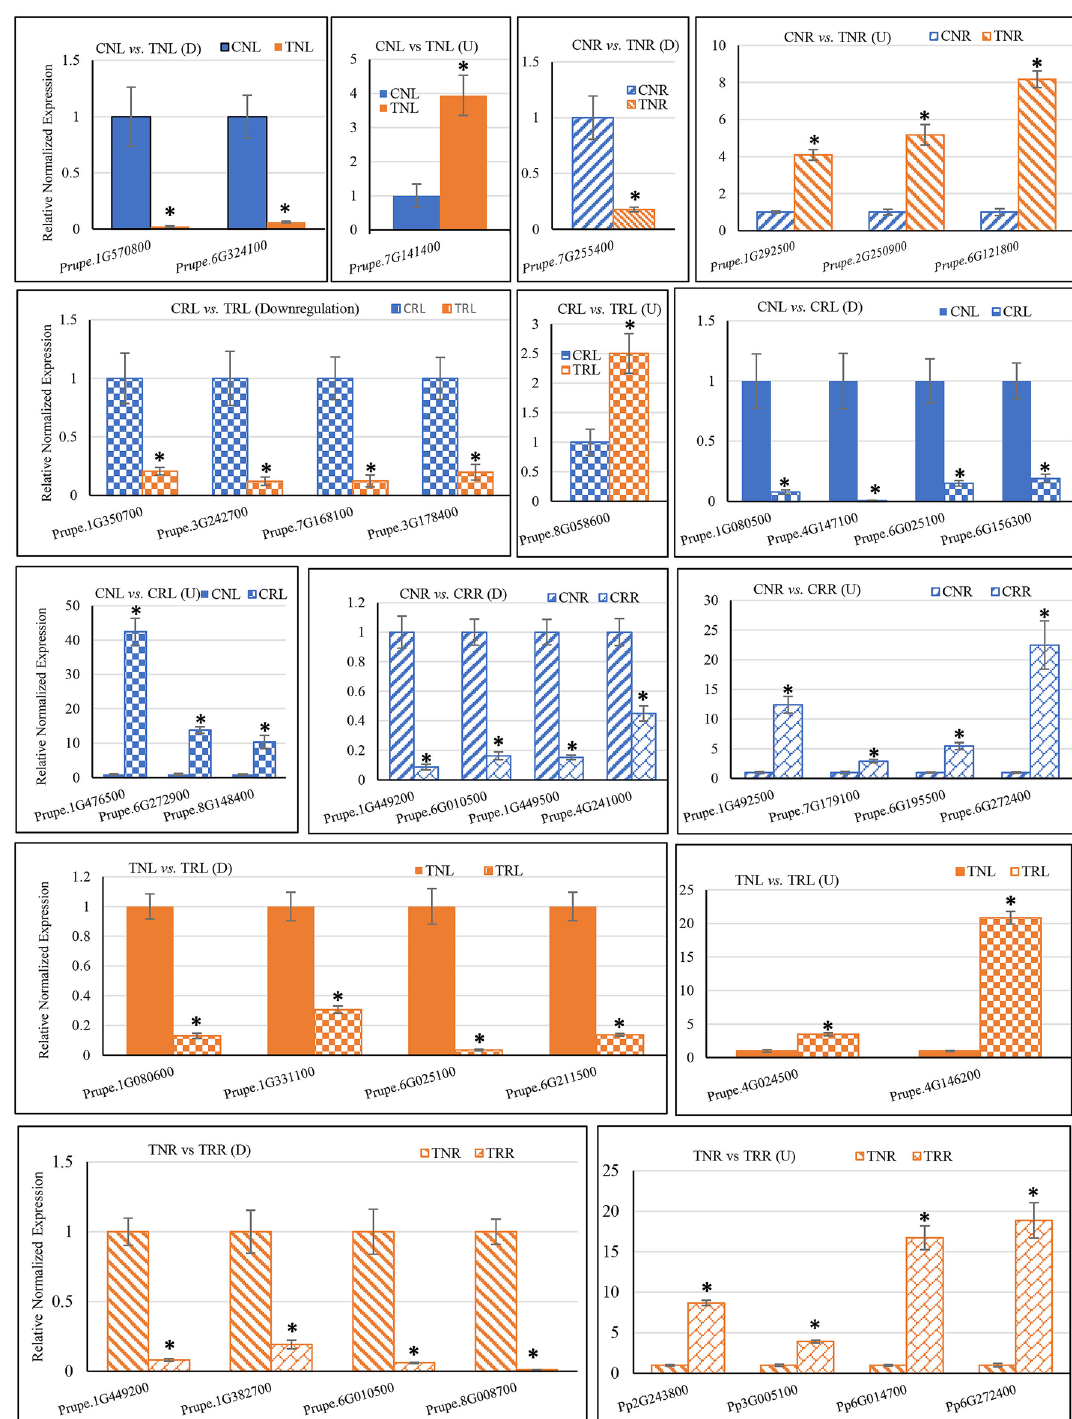
Figure 3. qRT-PCR validation of gene expression observed in RNA-Seq data. The Y -axis indicates relative normalized expression, and the X -axis indicates gene IDs. Samples used for the gene expression comparisons are shown on top of the graph. Graphs for downregulated (D) gene(s) and upregulated (U) genes are shown separately. The blue color indicates control (blue solid, CNL; blue diagonal stripes, CNR; blue large checkerboard, CRL; blue diagonal bricks, CRR), and the orange color indicates treatment (orange solid, TNL; orange diagonal stripes, TNR; orange large checkerboard TRL; and orange diagonal bricks, TRR). An asterisk (*) indicates a significant difference (t-test p ≤ 0.05). CNL, Control ‘Nemaguard’ Leaf; TNL, Treatment ‘Nemaguard’ Leaf; CNR, Control ‘Nemaguard’ Root; TNR, Treatment ‘Nemaguard’ Root; CRL, Control ‘Rootpac 40’ Leaf; TRL, Treatment Rootpac Leaf; CRR: control ‘Rootpac 40’ root; TRR, treatment ‘Rootpac 40’